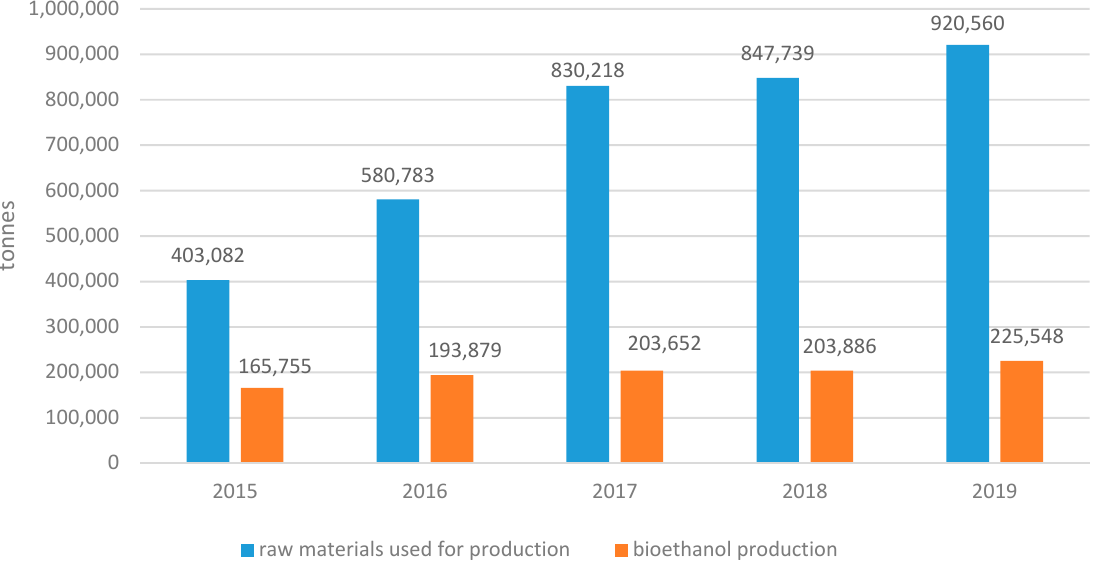
Figure 1. Volume of raw materials used for production and the volume of bioethanol production in Poland in 2015–2019 [51].